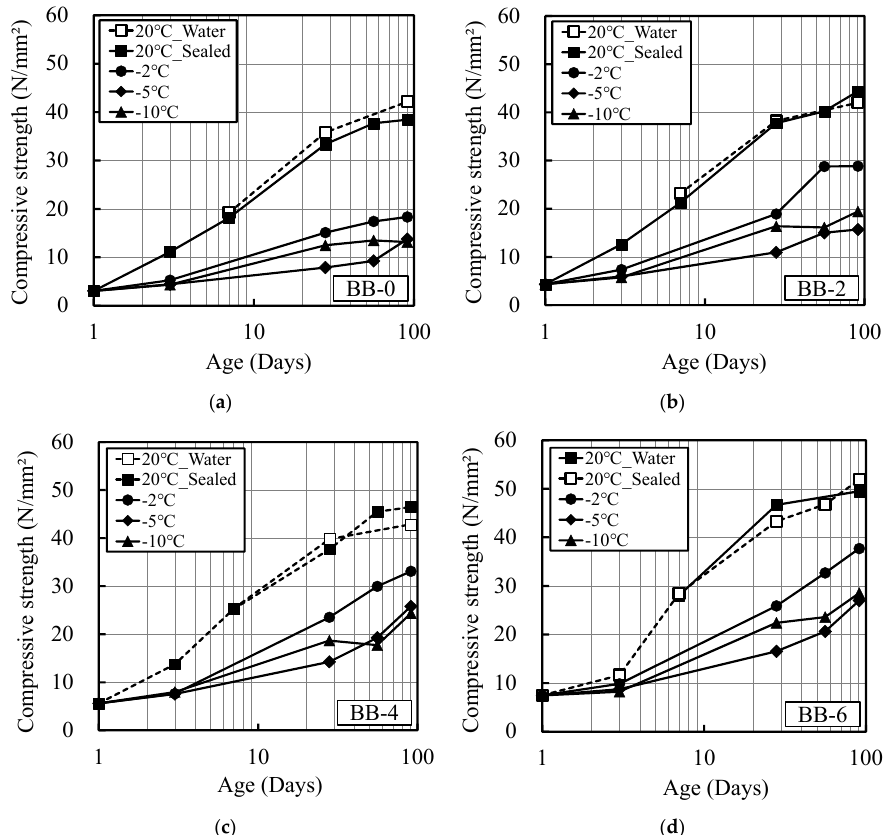
Figure 2. Relationship between compressive strength and age (BB),( a )BB-0;( b )BB-2;( c )BB-4;( d )BB-6.